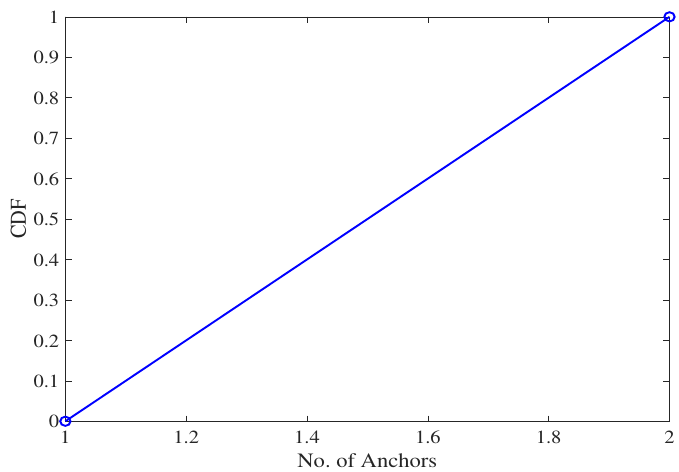
Figure 9. CDF of localization error for the proposed